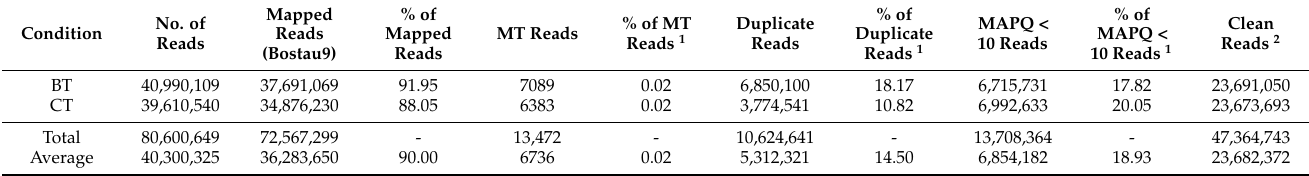
Table 1. CTCF ChIP-seq read statistics showing the number of reads, number and percentages of reads mapped, mitochondrial reads, duplicate reads and reads with mapping quality <10, and the number of clean reads used for peak